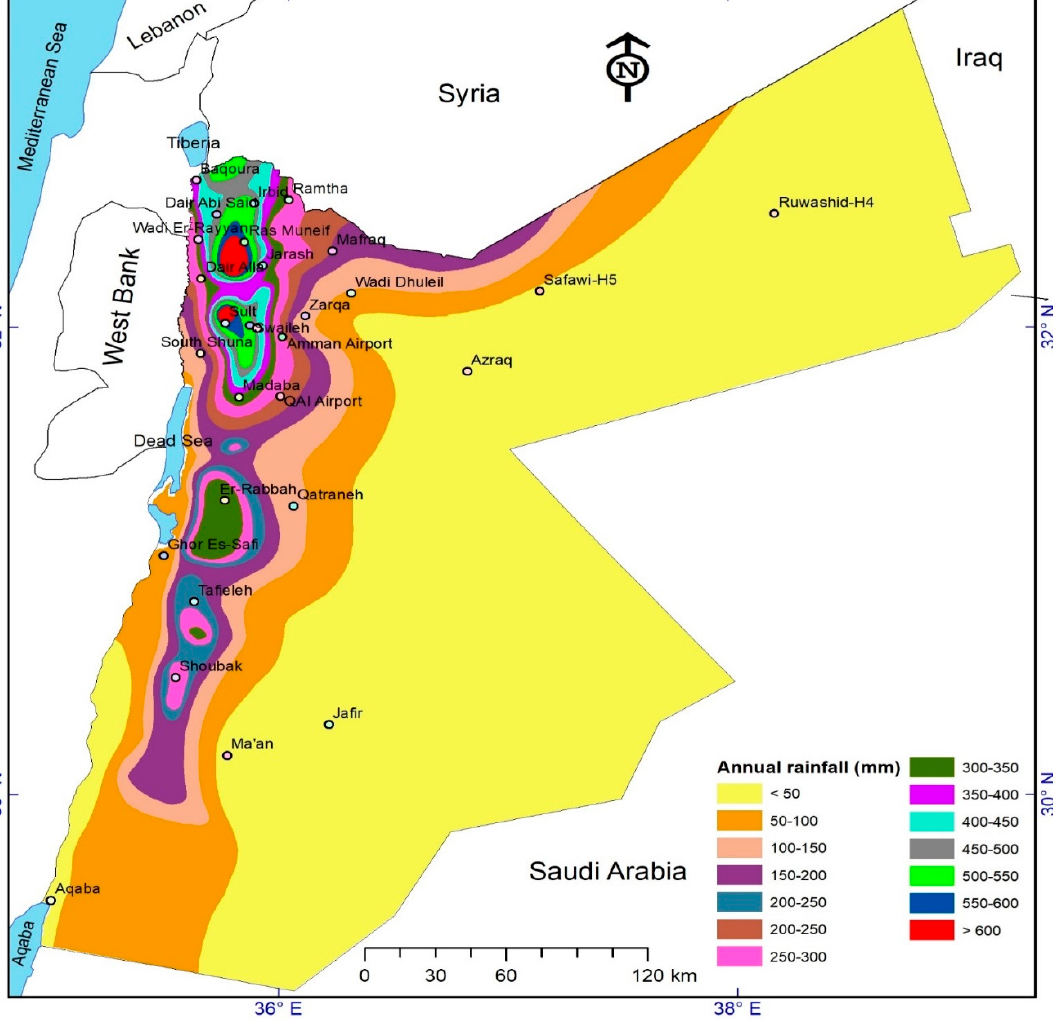
Figure 2. Rainfall Distribution map of the country based on long historical rainfall records (Modified after MWI, 2010).